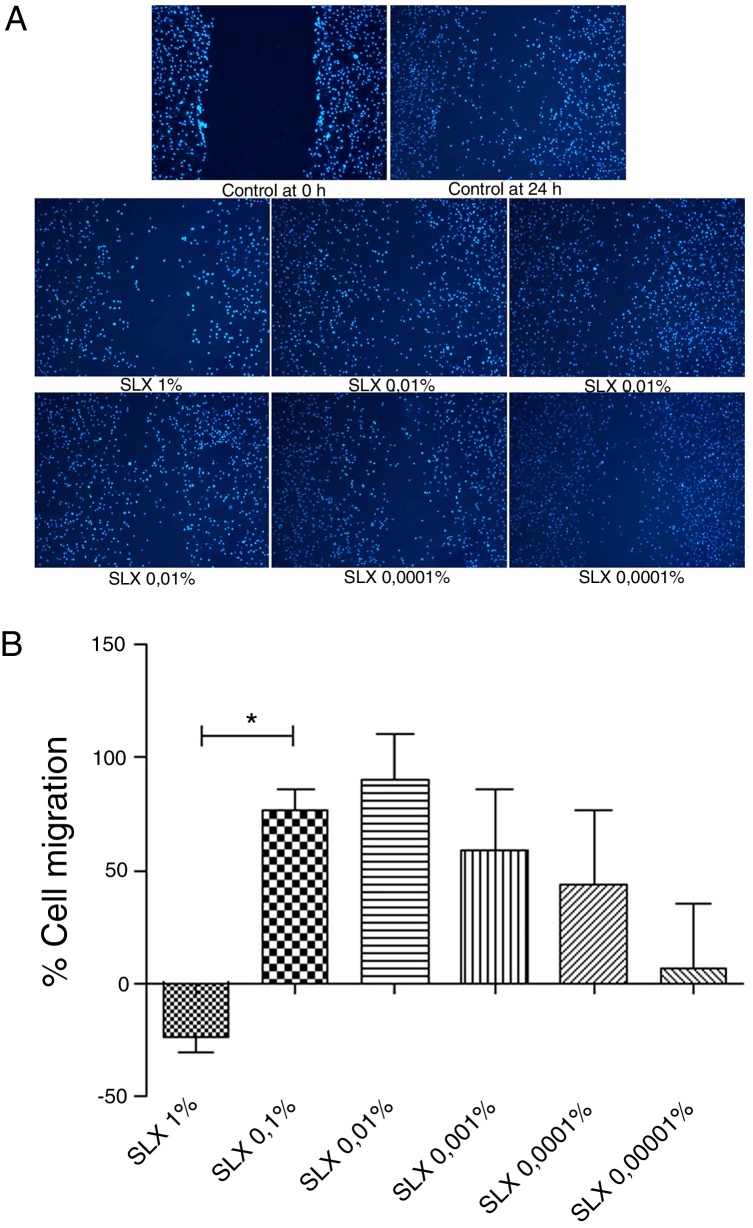
Cell migration. (A) Microscopic fluorescent 4′,6-diamino-2-phenyl-indole (DAPI) image of the scratch assay with human keratinocytes. Cell proliferation/migration in the scratch assay was observed in response to an “artificial lesion” treated with different concentrations of latex serum. (B) Percentage of proliferation/migration of human keratinocytes relative to basal culture medium, set to 0 on the X-axis, distributed at various concentrations of latex serum (SLX) treated for 24 h in culture. Values represent mean ± standard error of mean (SEM) of triplicate results. ANOVA statistical test, Bonferroni post-test. *Corresponds to a significant difference (p < 0.05) between groups (magnification: 50×).